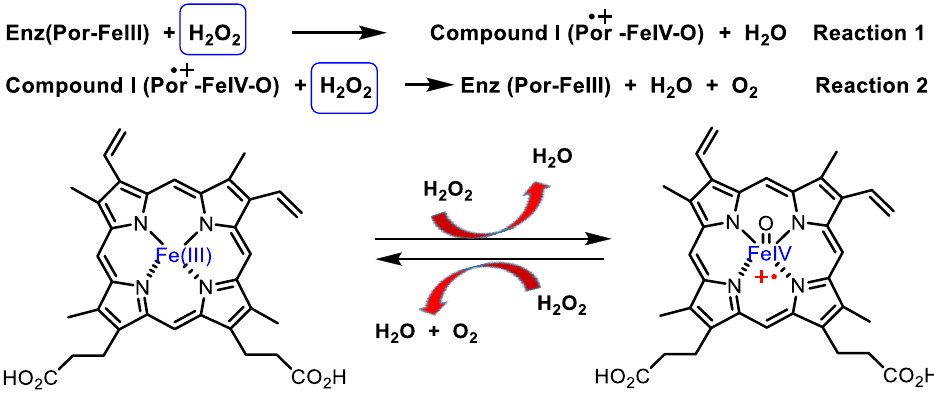
Figure 14. Catalase mechanism of hydrogen peroxide dismutation to water and oxygen.